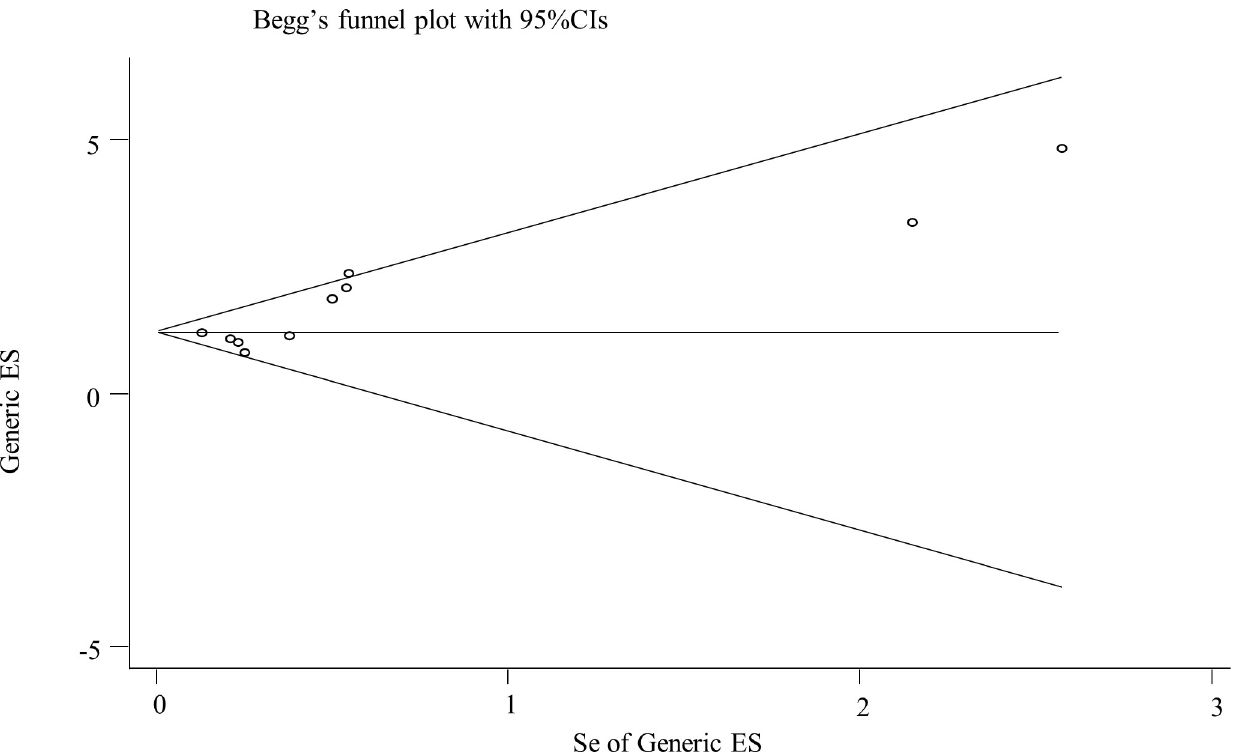
Fig 5. Begg’s funnel plot for publication bias assessment of all included studies. ES, effect size; se, standard error.